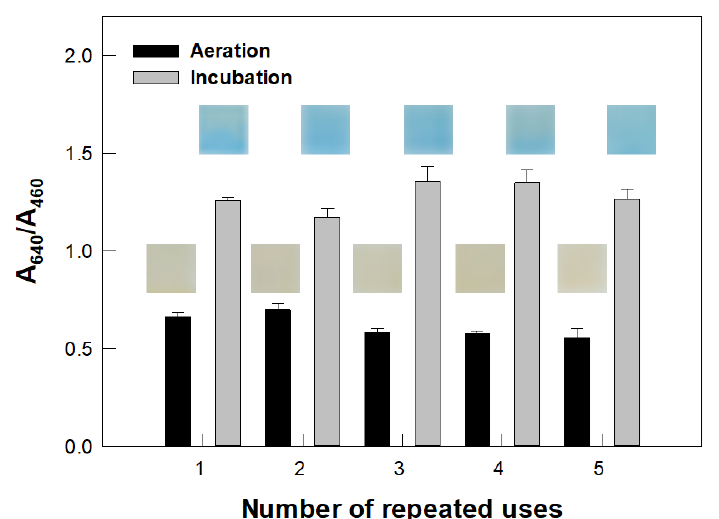
Figure 7. Reusability of the colorimetric film sensor. The A 640 /A 460 values and photographs (showing colors) of a sensor reused five times are presented.